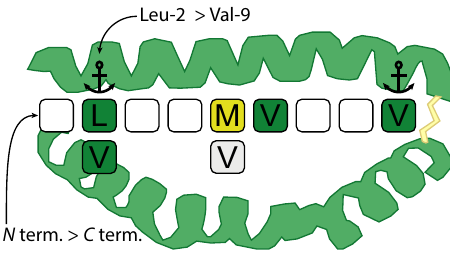
Fig. 8 Favored amino acid positions within the HLA-A*02:01 peptide- binding pocket. Native MS con fi rms Leu-2 in the B pocket and Val-9 in the F pocket respectively as the main anchor positions of the pMHC. The analysis of truncated NV9 variants reveals that Val-2 is also a favored binding site. Moreover, Met-5 or Val-5, as well as Val-6, also contribute signi fi cantly to binding under certain circumstances. Among the anchor residues, Leu-2 contributes signi fi cantly more to the binding than Val-9. Concerning the termini, the N -terminus is of greater importance for binding than the C